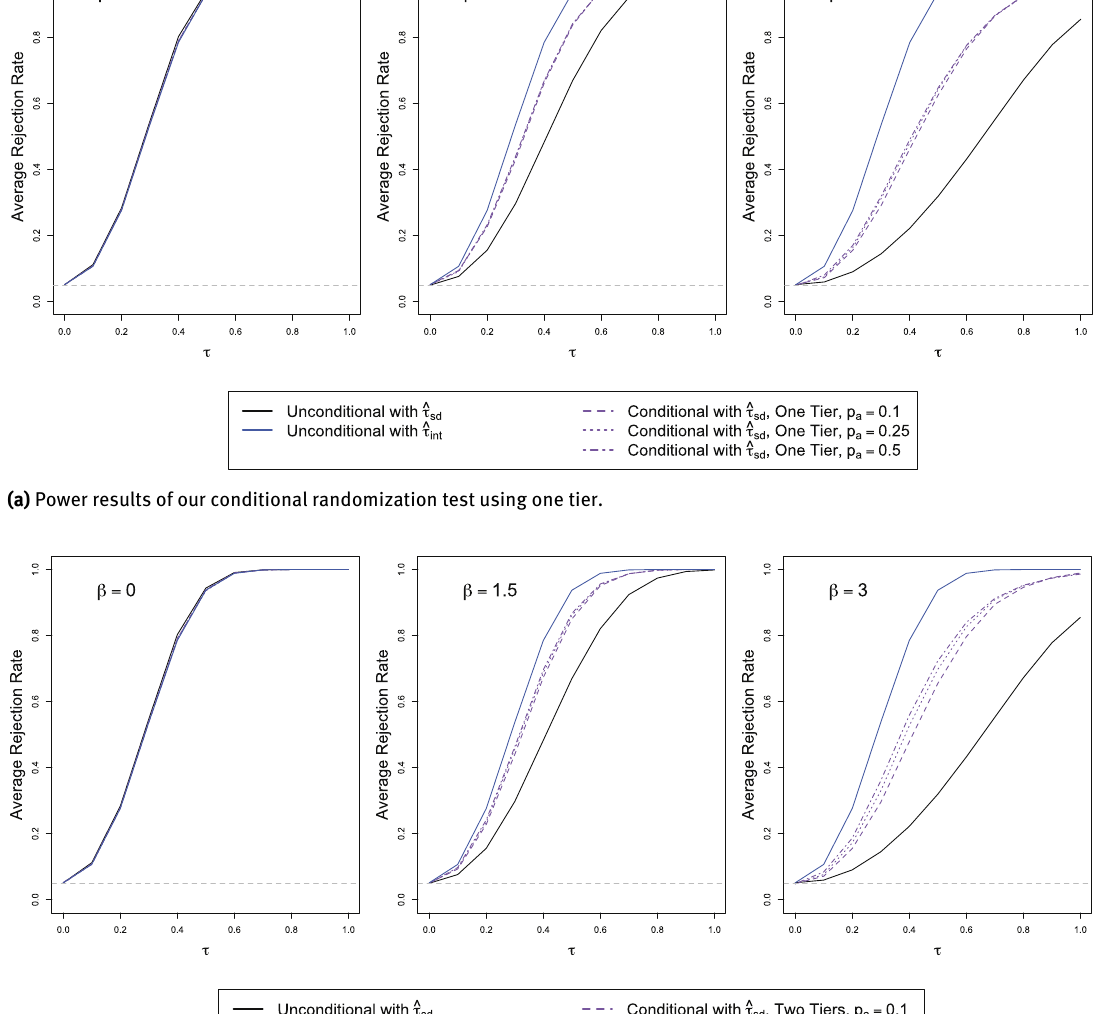
4. when the linear regression used in